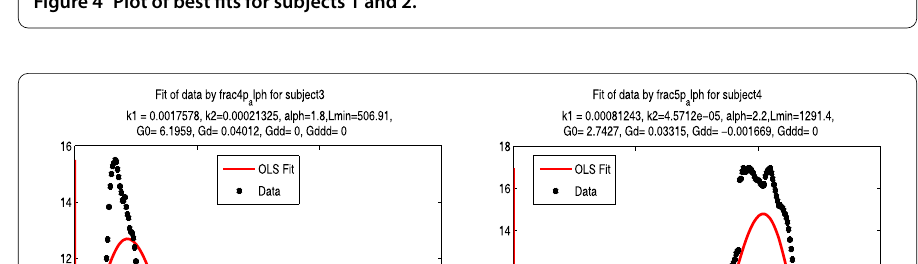
Figure 4 Plot of best fits for subjects 1 and 2.